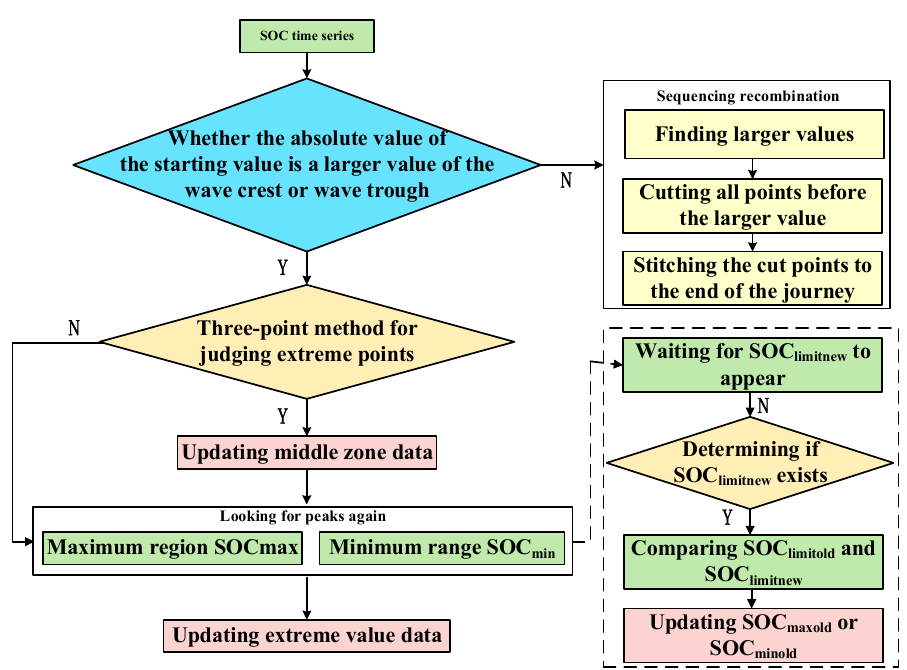
Figure 3. Improvement of the Rainflow process.